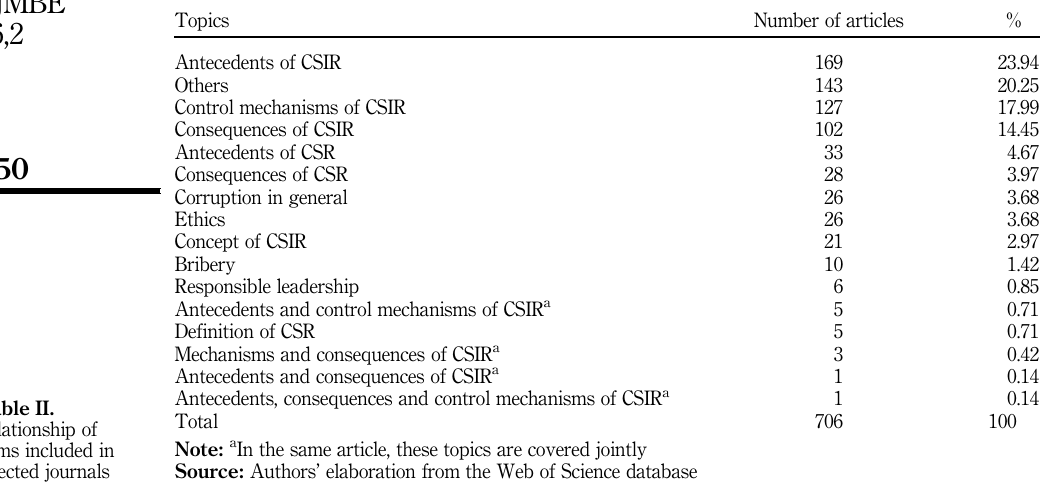
items included in selected